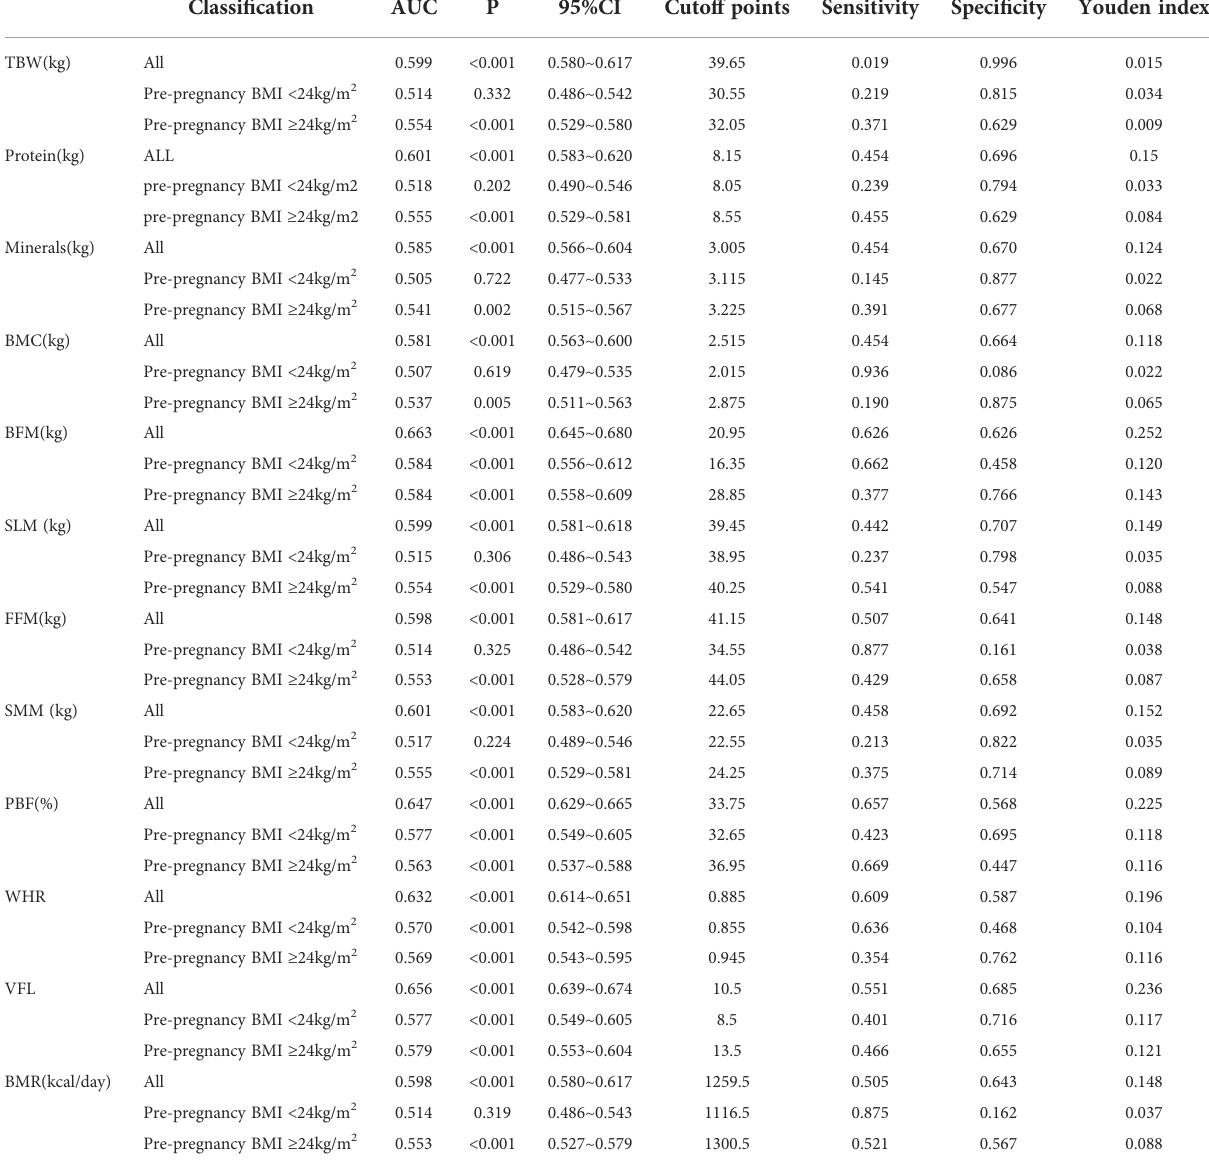
TABLE 6 Analysis of the predictive effect of different pre-pregnancy BMI lower body composition indexes on GDM. Classi fi cation